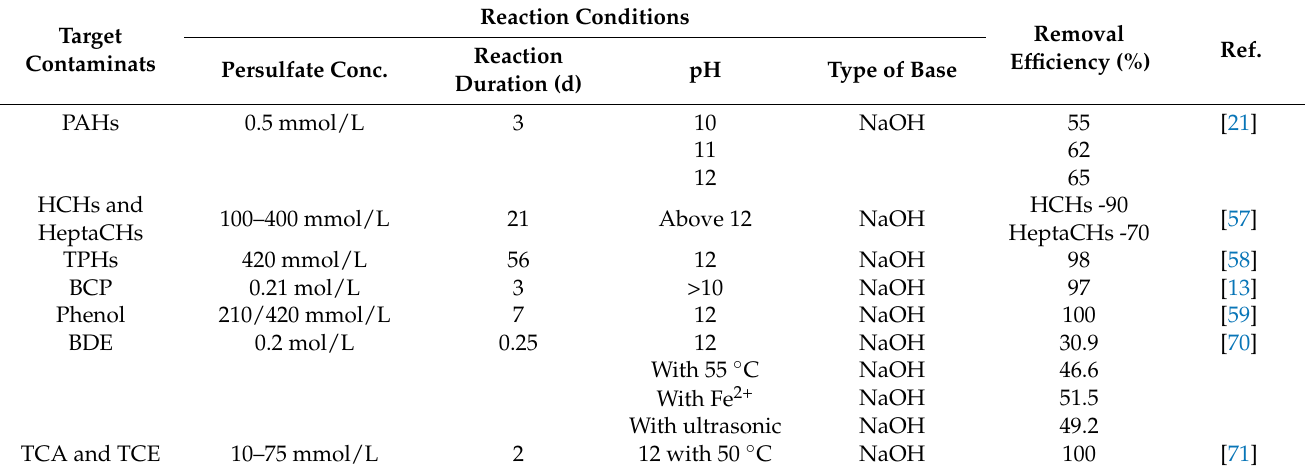
Table 2. Bench scale and laboratory studies with alkaline-activated persulfate. Reaction Conditions Target Contaminats